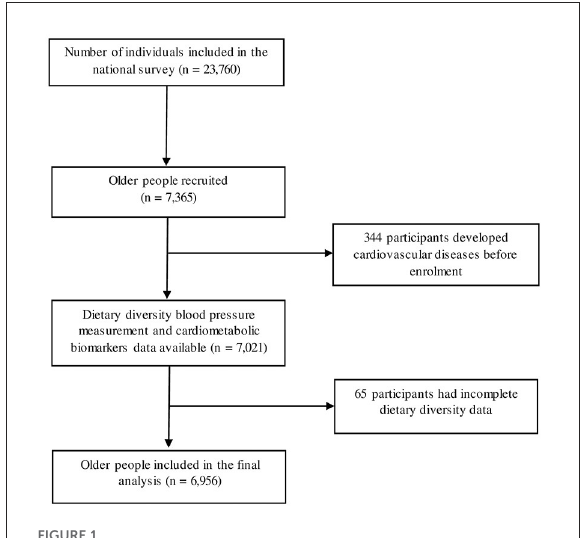
FIGURE1 Flow diagram of study participants included in the analysis.